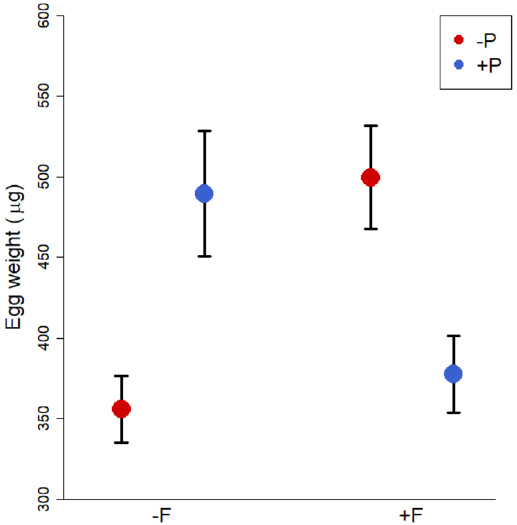
Figure 1. Mean weight per egg ( μ g) of the first clutch laid by females reared with ( + F) or without (-F) older group members that were exposed to predator experience ( + P treatment, blue) or no predator experience ( − P treatment, red). Means ± SE are